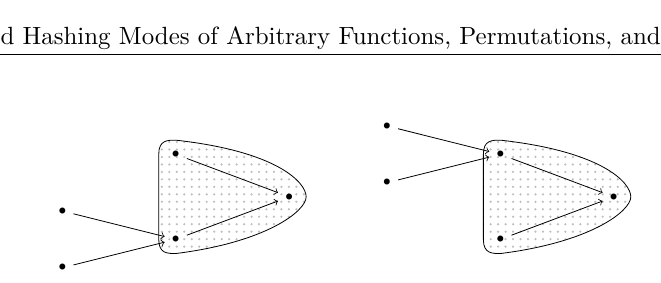
Figure 4: Example of a hashing mode that is subtree-free but not radical-decodable. The hashing mode only allows for the two depicted templates with three message blocks. The subtree with a solid line is a common final